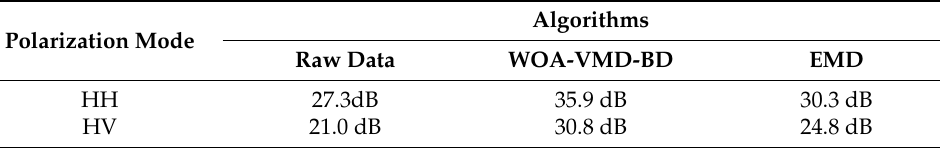
Table 2. Signal-to-noise ratio of data before and after